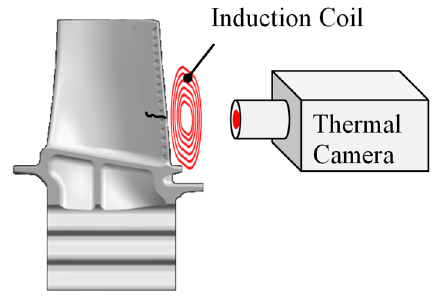
Figure 22 . Principle inductive thermography . Figure 23. Principle inductive